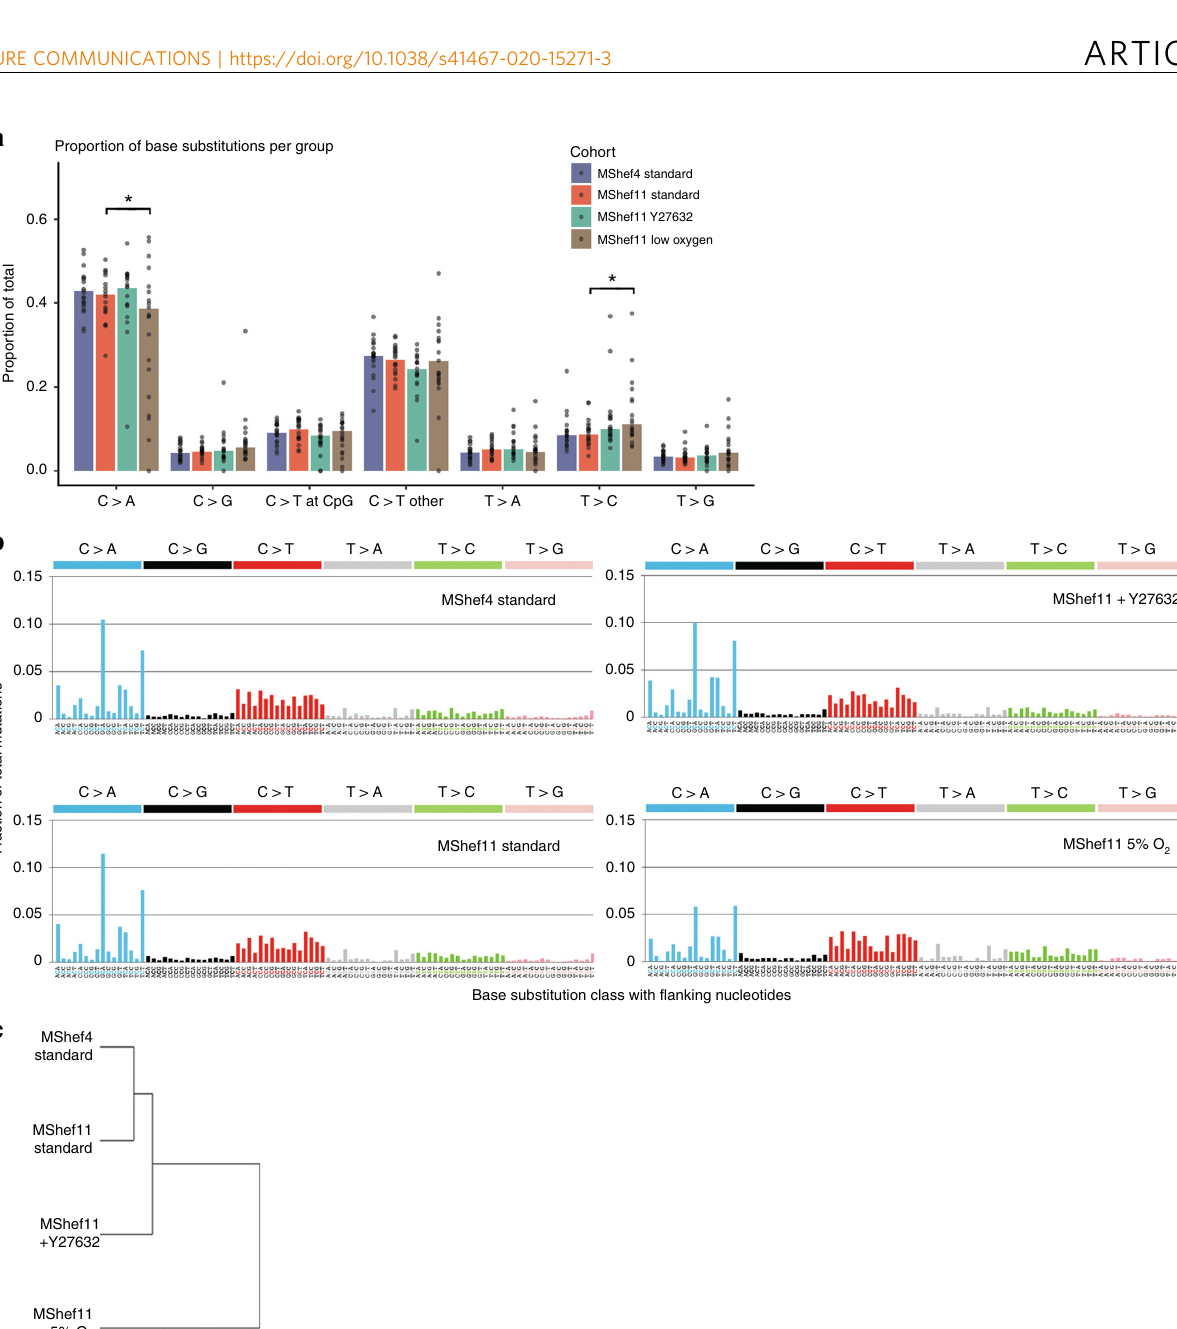
Fig. 3 Pattern of base substitutions and mutation signatures. a Bar and dot chart showing low-resolution mutational spectra and proportions of each of seven point mutation classes detected in MShef4 standard ( N = 20), MShef11 standard ( N = 19), MShef11 + Y27632 ( N = 20), and MShef11 low oxygen ( N = 21) subclones. Bars indicate the mean proportion of each class of mutation for each cell line/growth-condition group; dots indicate individual subclones in each group. C > A transversions and C > T transitions are most prevalent in the data. A two-tailed t -test showed MShef11 cultured in low oxygen to have a signi fi cant reduction in C > A transversions compared to standard conditions ( P = 0.037) whilst Wilcoxon testing also showed a small increase in T > C transitions ( P = 0.045). b High-resolution mutational spectra derived from the combined mutation data all subclones grown in each growth-condition. Each of the six possible point mutations is subdivided into 16 classes on the basis of the 5 ’ and 3 ’ nucleotides fl anking the mutation, resulting in 96 possible substitution classes. C:G > A:T and C:G > T:A mutations are most prevalent in the data. These spectra can be correlated with 30 mutation signatures annotated in the Catalogue of Somatic Substitutions in Cancer (COSMIC) database 53 to explore the aetiology of mutation. c Dendrogram showing the similarity of all growth-condition groups based on their mutational pro fi les. MShef4 and MShef11 cultured in standard conditions exhibited the most similar mutational pro fi les, whereas the low oxygen condition is the most dissimilar in mutation pro fi le compared to all other groups. Source data are provided in Supplementary Data